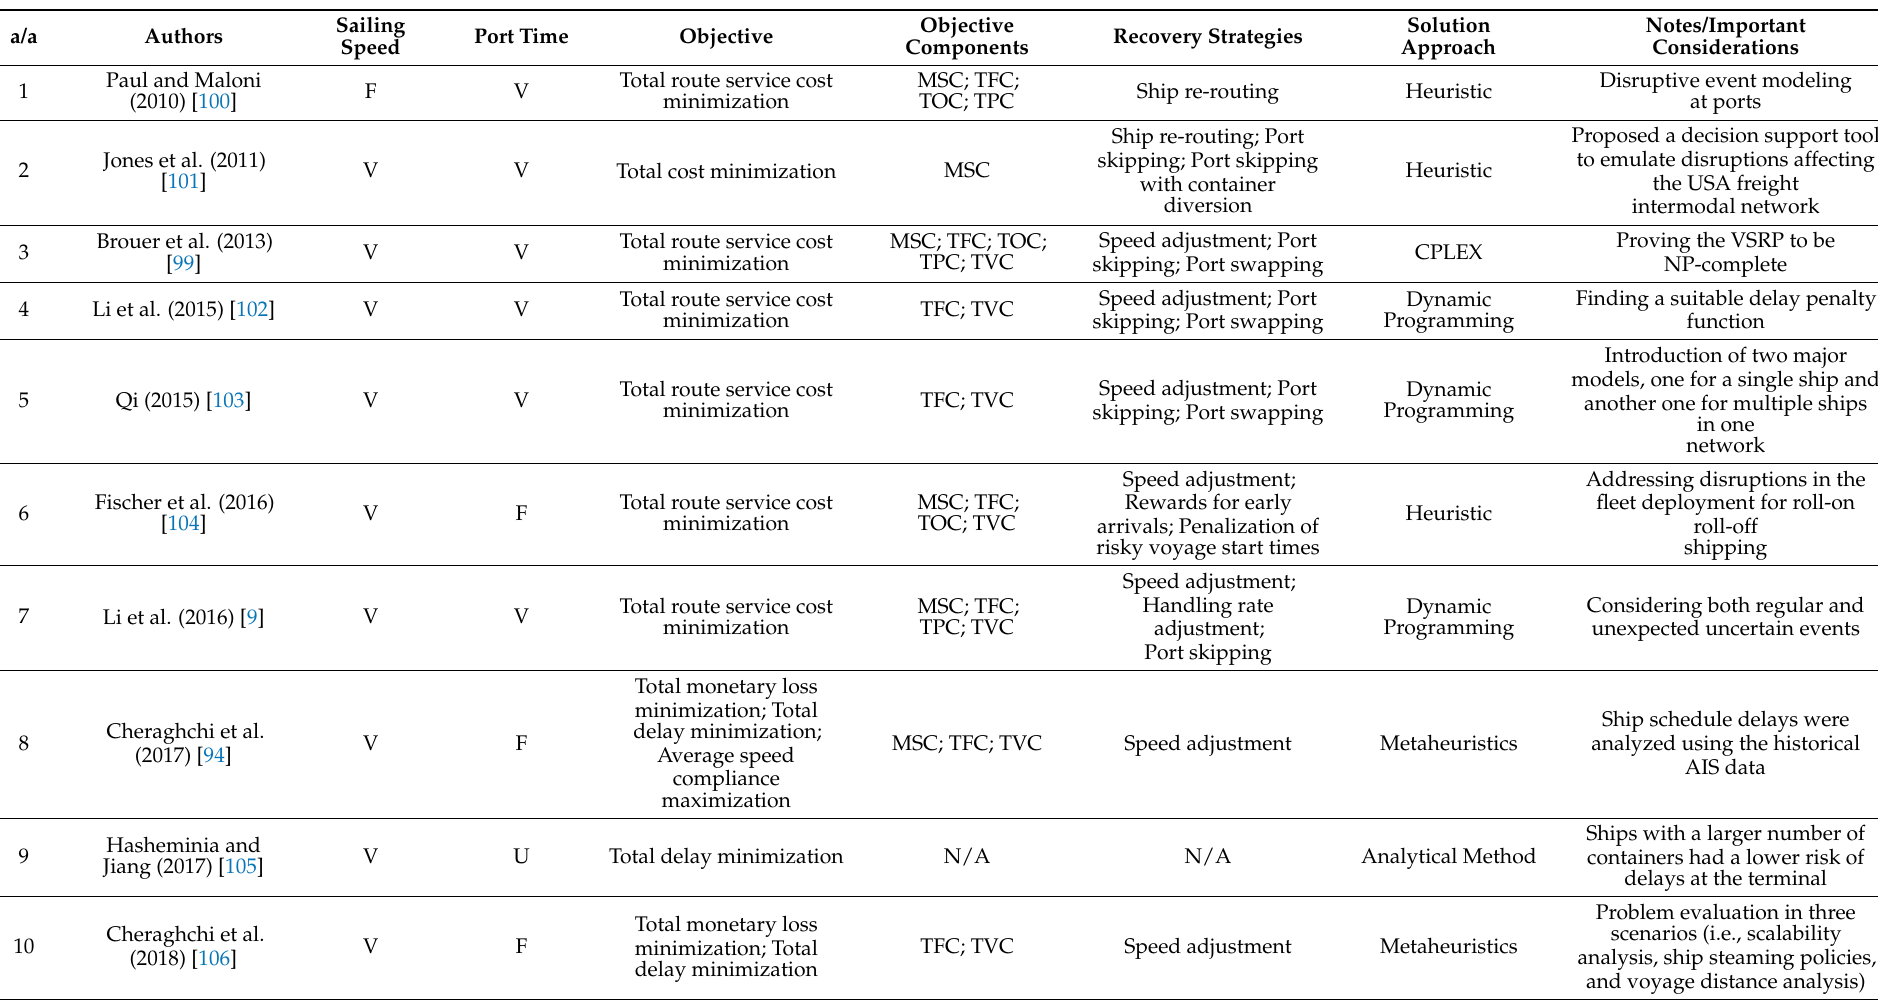
Table 2. Summary of the reviewed studies on ship schedule